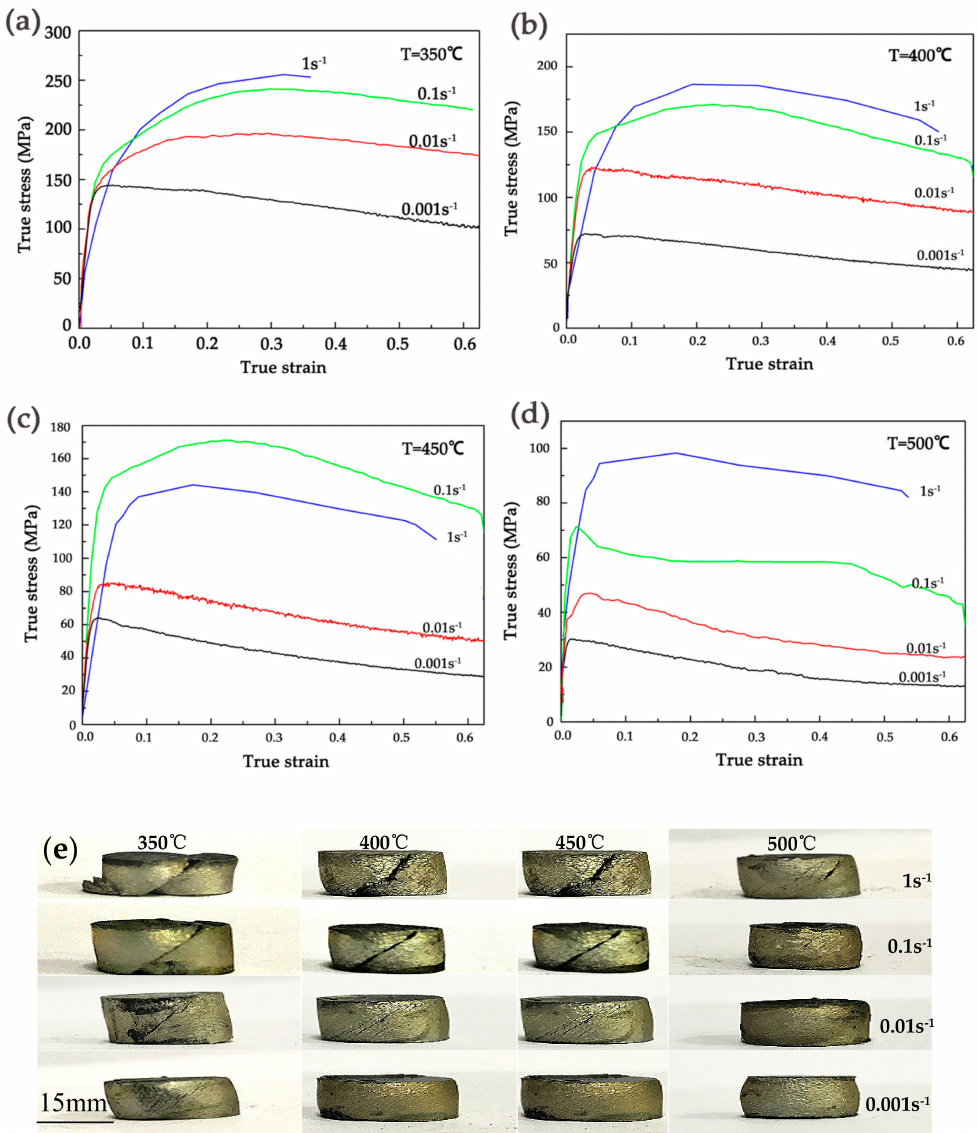
Figure 4. True stress-strain curves of the homogenized alloy compressed at the temperature of ( a )